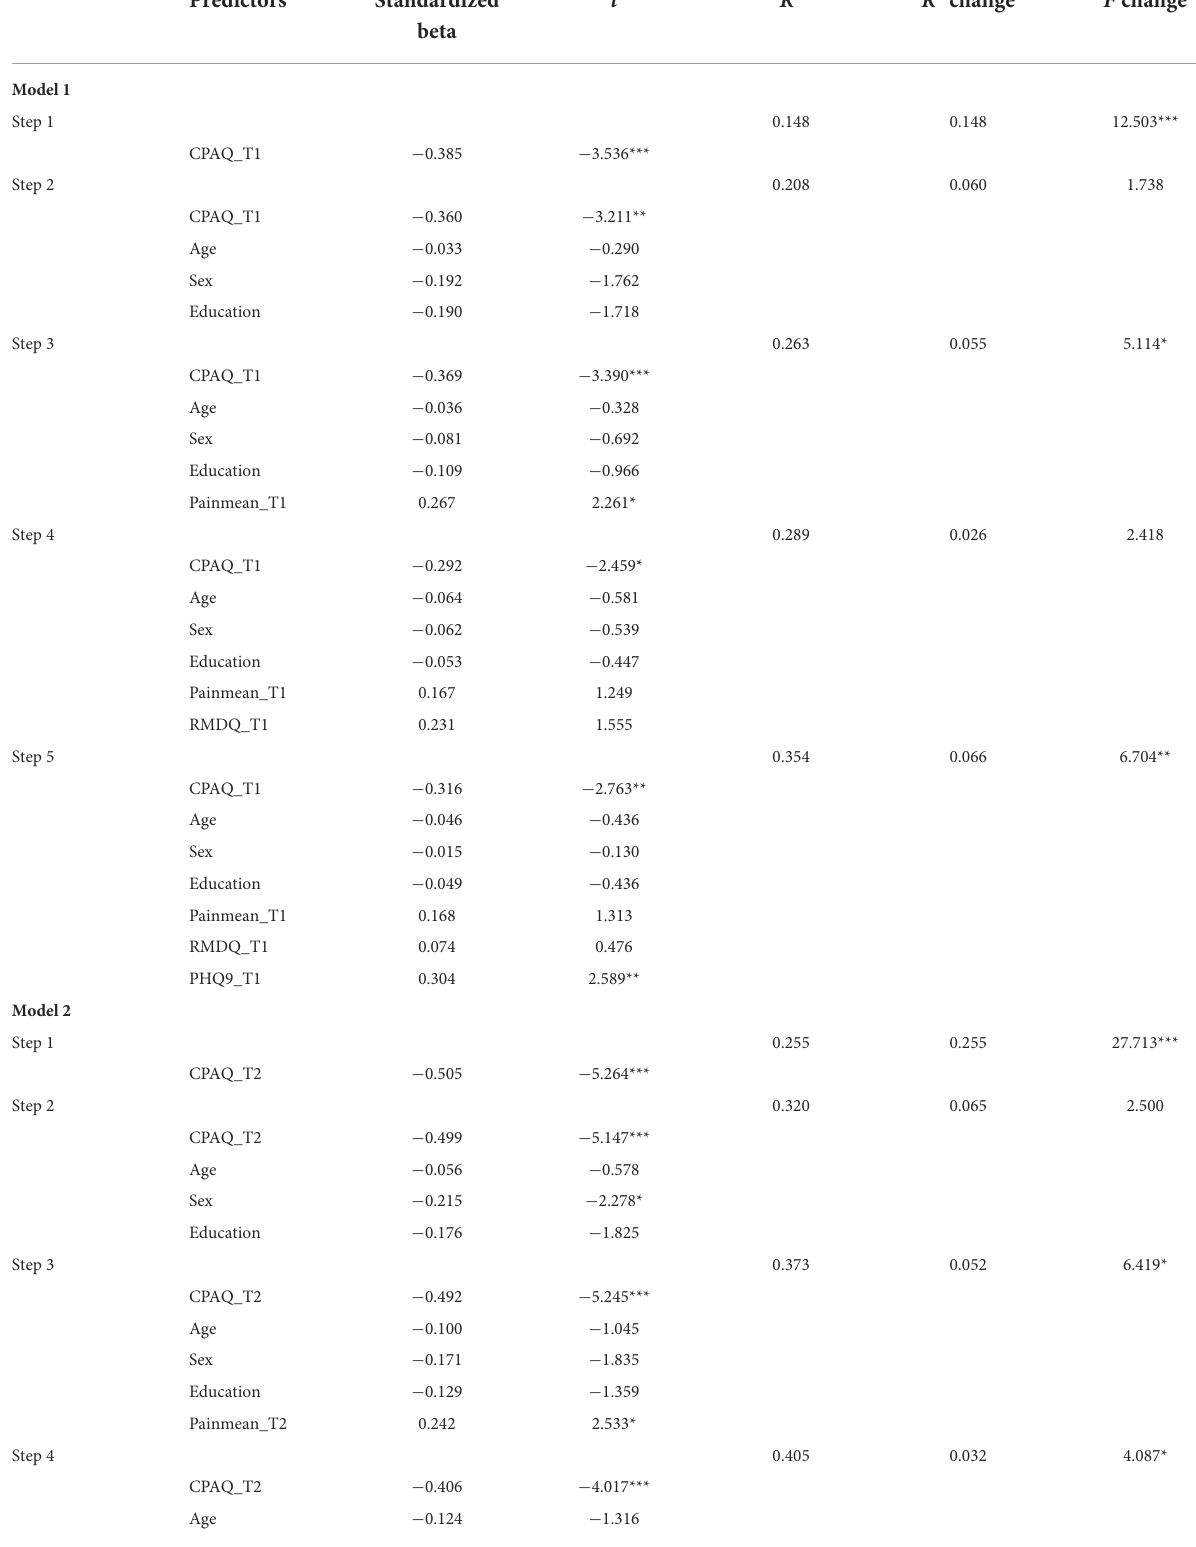
TABLE 4 Biopsychosocial predictors (assessed at baseline in Model 1 vs. at follow up in Model 2) of follow-up illness intrusiveness in patients with chronic low-back pain (hierarchical multiple regression).